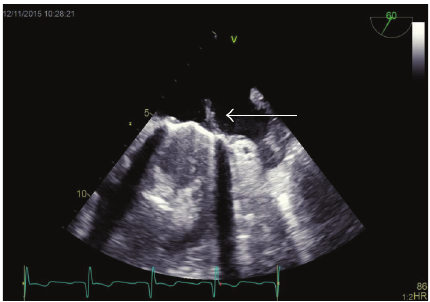
Figure 3: Transesophageal echocardiography of the mitral valve prosthesis after thrombolysis. The thrombus is no longer visible. Normal movement of the disks of the bileaflet valve is